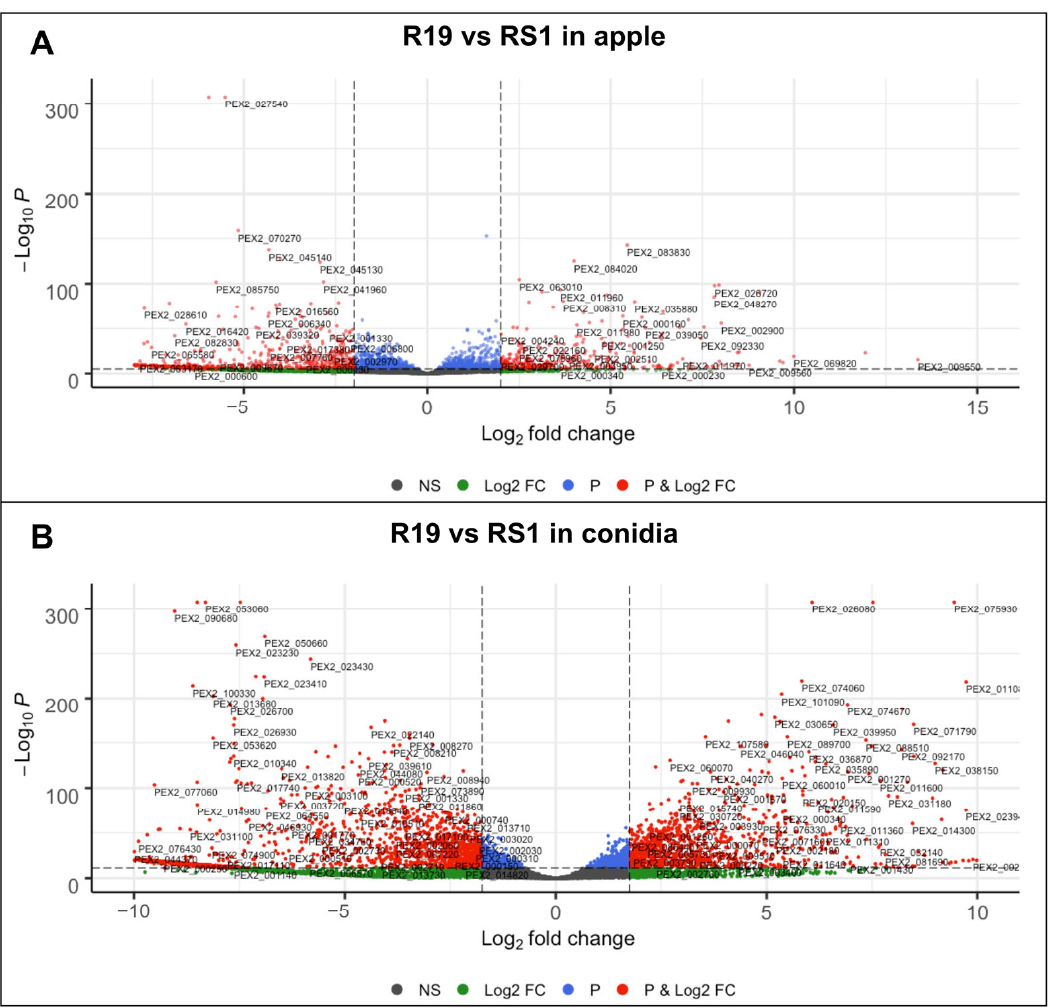
Figure 4. Volcano plots of differential gene expression between Penicillium spp. R19 and RS1. Differential gene expression in R19 and RS1 from ( A ) ramifying hyphae and mycelium in apple fruit and ( B ) ungerminated conidia. Green = log 2 fold change, black = not significant, p = significant p -value ( p < 0.05), and red = log 2 fold change with a significant p -value ( p < 0.05). Dotted lines indicate log 2 fold change ≥ 2 threshold.